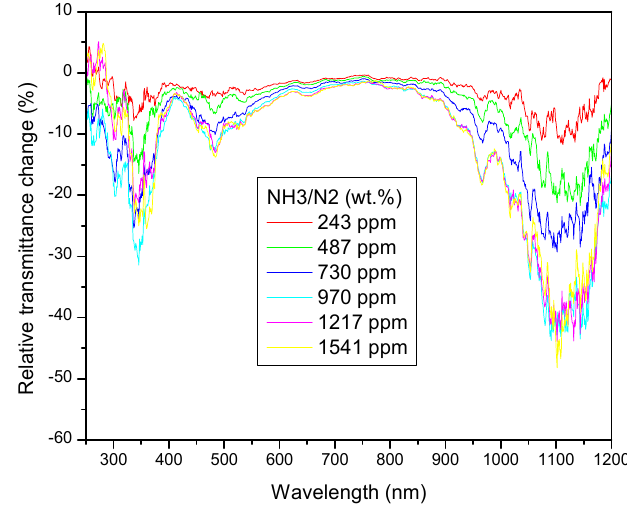
Figure 7. Relative changes in the spectral transmittance observed under subsequent expositions to NH 3 /N 2 gas mixtures of the indicated composition.